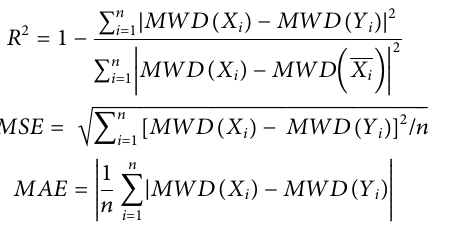
Frontiers in Earth Science |